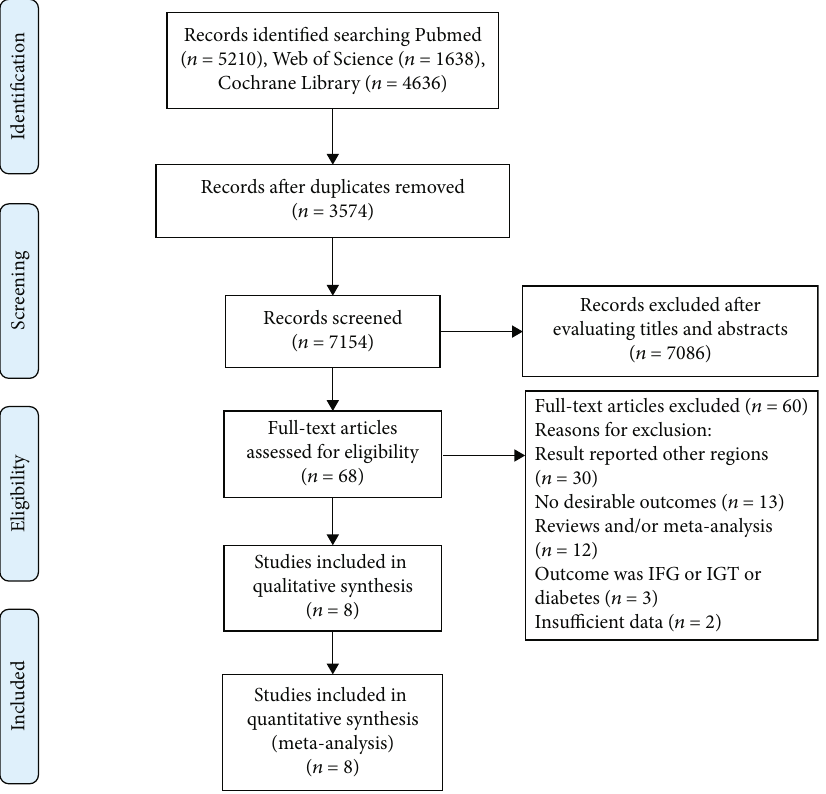
Figure 1: Flow diagram of the literature search and study selection process in the